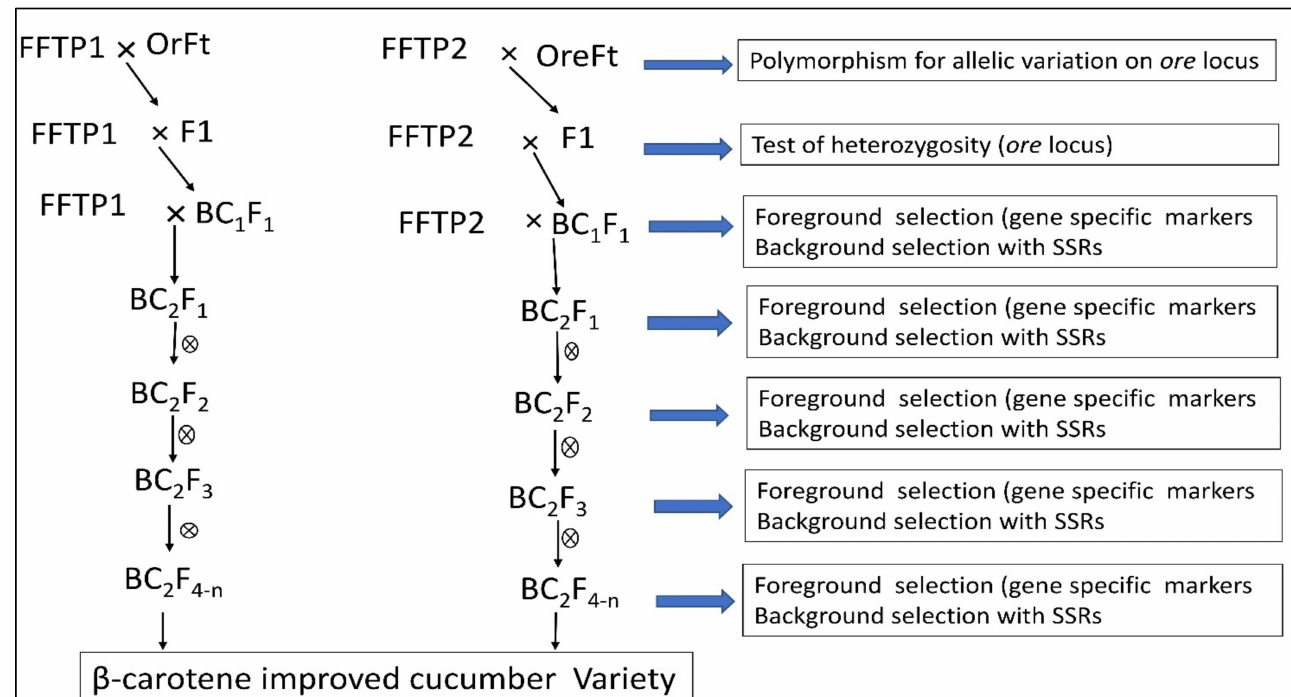
Figure 3. Marker assisted selection (MAS) strategy for utilization of ore recessive genes for develop- ment of an early flowering cucumber with enhanced β -carotene content. The phenotype description of above genes is based on the previous studies. OreFt, orange endocarp and early female flowering; fft, first female flowering time; P1, parent 1; P2, parent 2, Selfing, ⊗